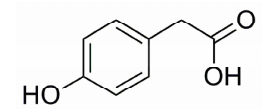
Figure 10. The chemical structure of